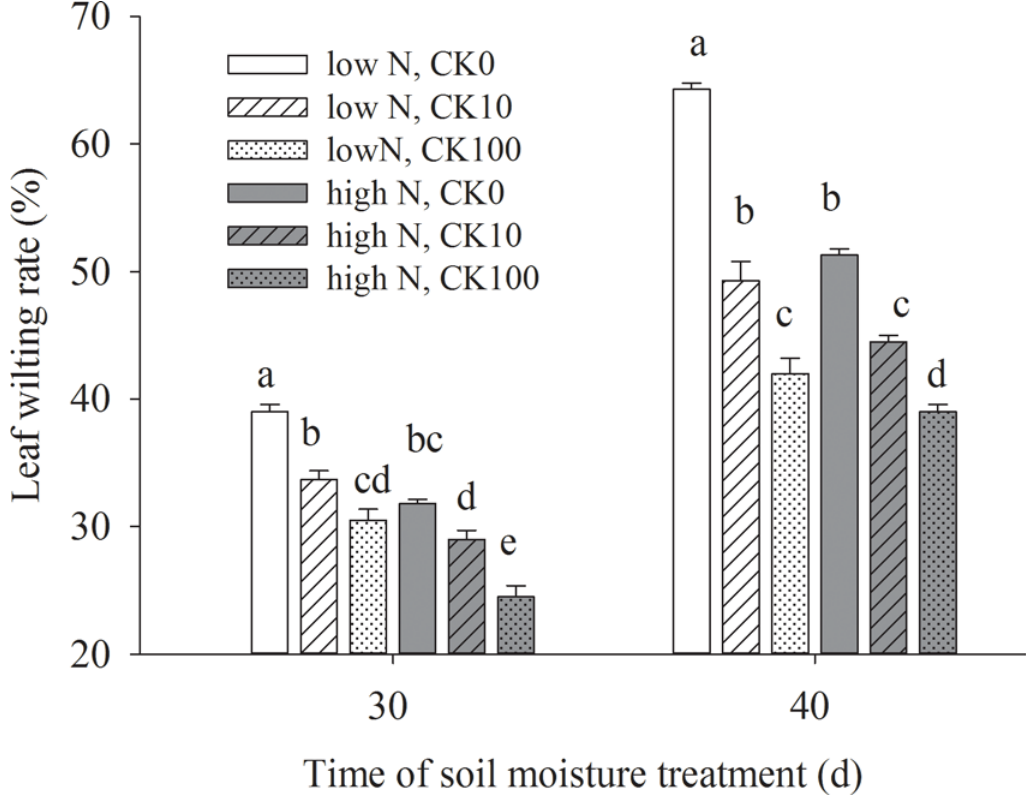
Fig 1. Effects of cytokinin trans -zeatin riboside (CK) and nitrogen on leaf wilting rate of creeping bentgrass under drought stress. Different lowercase letter means significant difference (P < 0.05) between treatments on the same day.